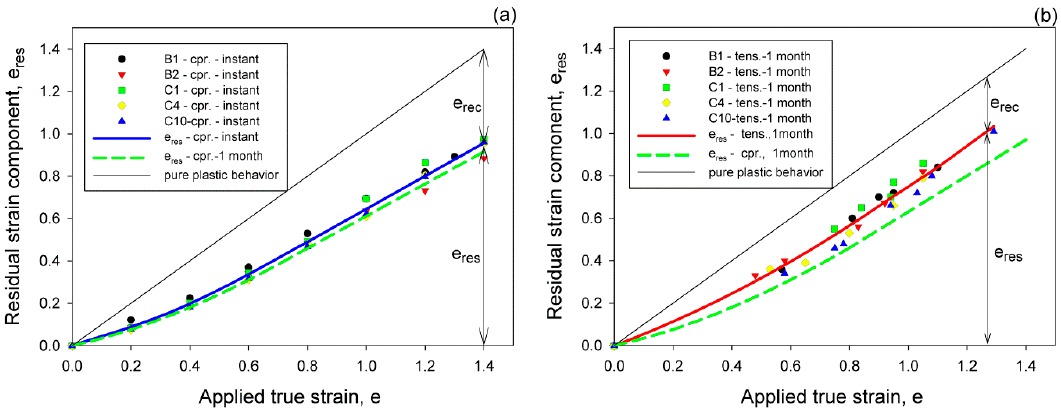
Figure 2. The strain recovery after: plane-strain compression ( a ); and tension ( b ). In ( a ), the points represent an instant recovery, determined few minutes after sample unloading. Thick solid line illustrates the instant recovery behavior while the dashed line shows the recovery after a one-month period (lines calculated as the fourth-order regression lines for data of all samples). In ( b ), the points represent the one-month recovery after tension. Thick solid line illustrates here the one-month tensile recovery while the dashed line the one-month compression recovery.